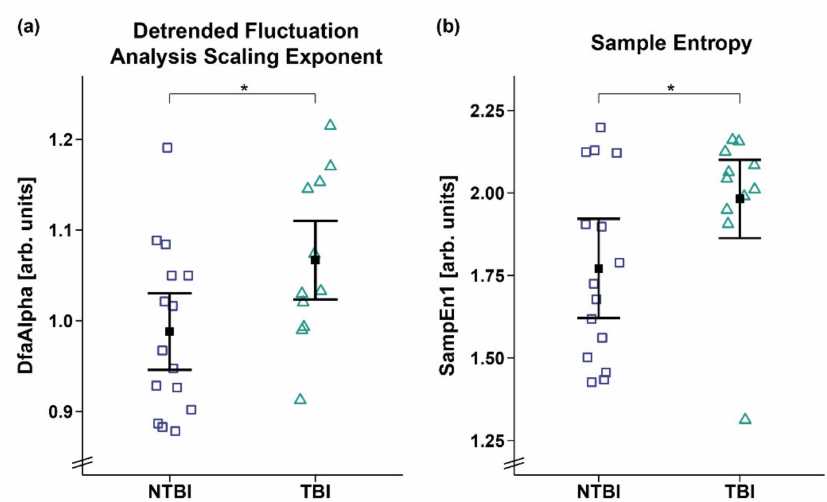
Figure 6. Detrended fluctuation analysis scaling exponent (DfaAlpha) and sample entropy 1 (Sam- pEn1). Patients with TBI showed a higher ( a ) DfaAlpha and ( b ) SampEn1 as compared to patients with NTBI. Error bars represent the mean and 95% confidence interval. * p < 0.05. Abbreviations: NTBI = non-traumatic brain injury; TBI = traumatic brain injury; arb. units = arbitrary units.